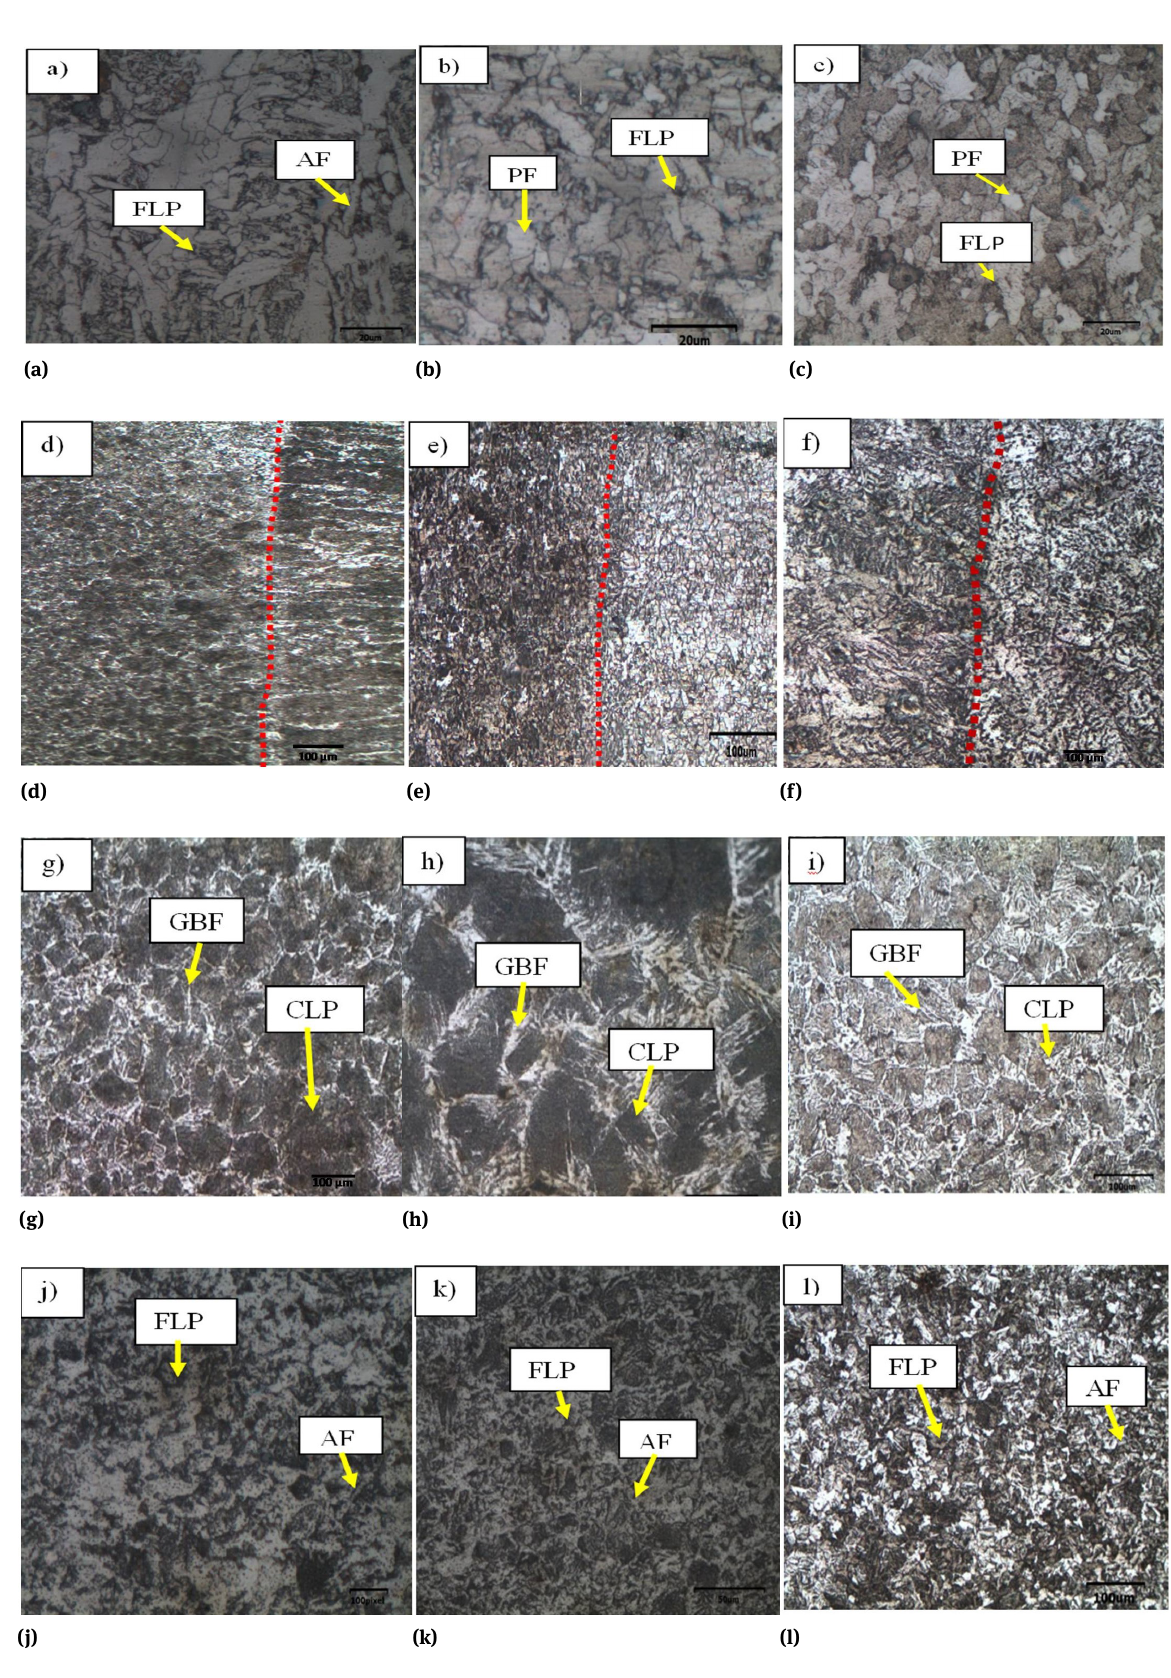
Figure 7: Different region optical micrographs of top, bottom and middle pass of the weld